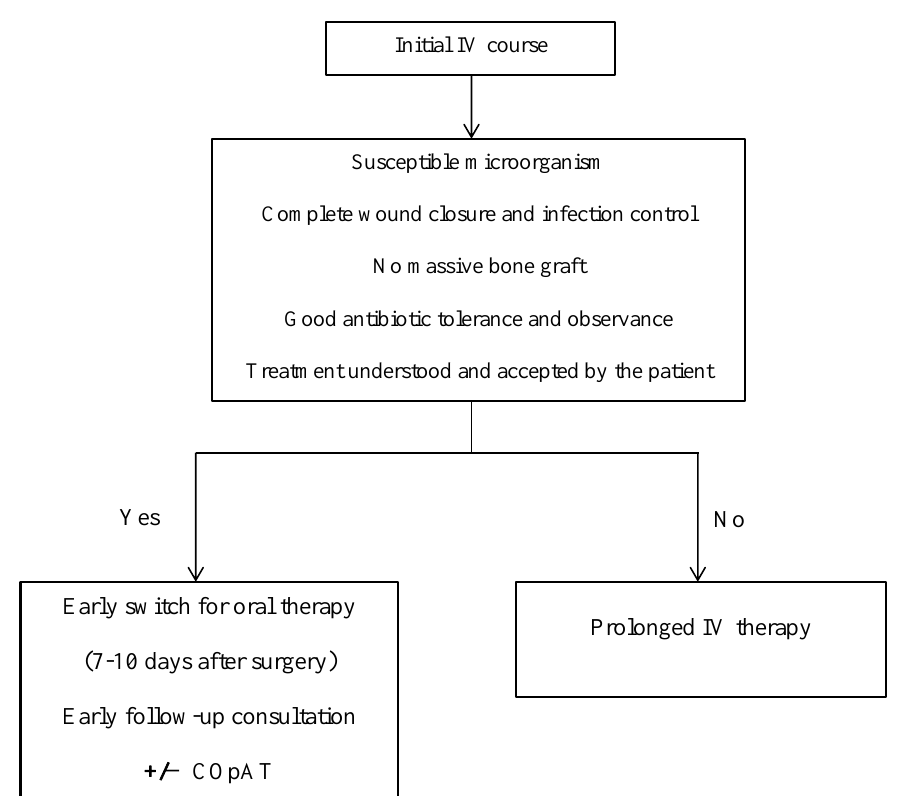
Figure 1. Initial intravenous therapy and indications to oral switch. IV: intravenous; COpAT: complex outpatient antibiotic Figure 1 : Initial intravenous therapy and indications to oral switch IV: intravenous; COpAT : complex outpatient antibiotic therapy